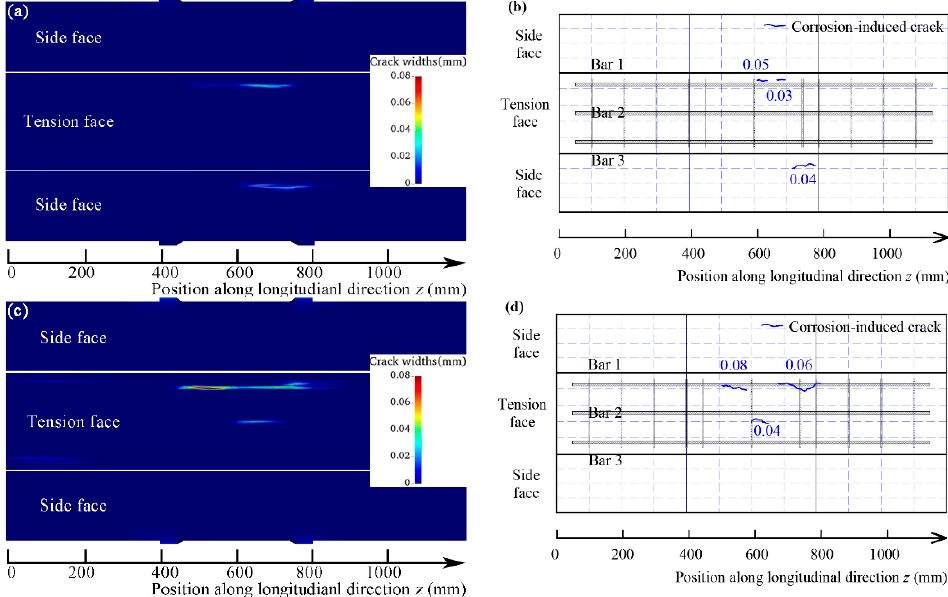
Figure 8. The corrosion-induced cracking pattern on beam surface: ( a ) prediction results of L00, ( b ) experimental results of L00, ( c ) prediction results of L60, and ( d ) experimental results of L60.